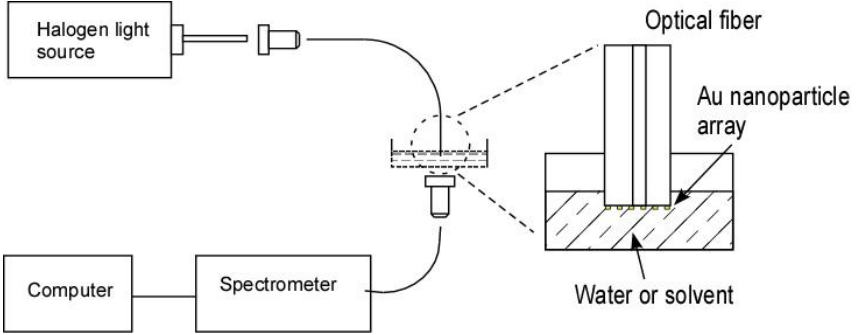
Figure 3. Optical setup for the fiber tip localized surface plasmon resonance sensor